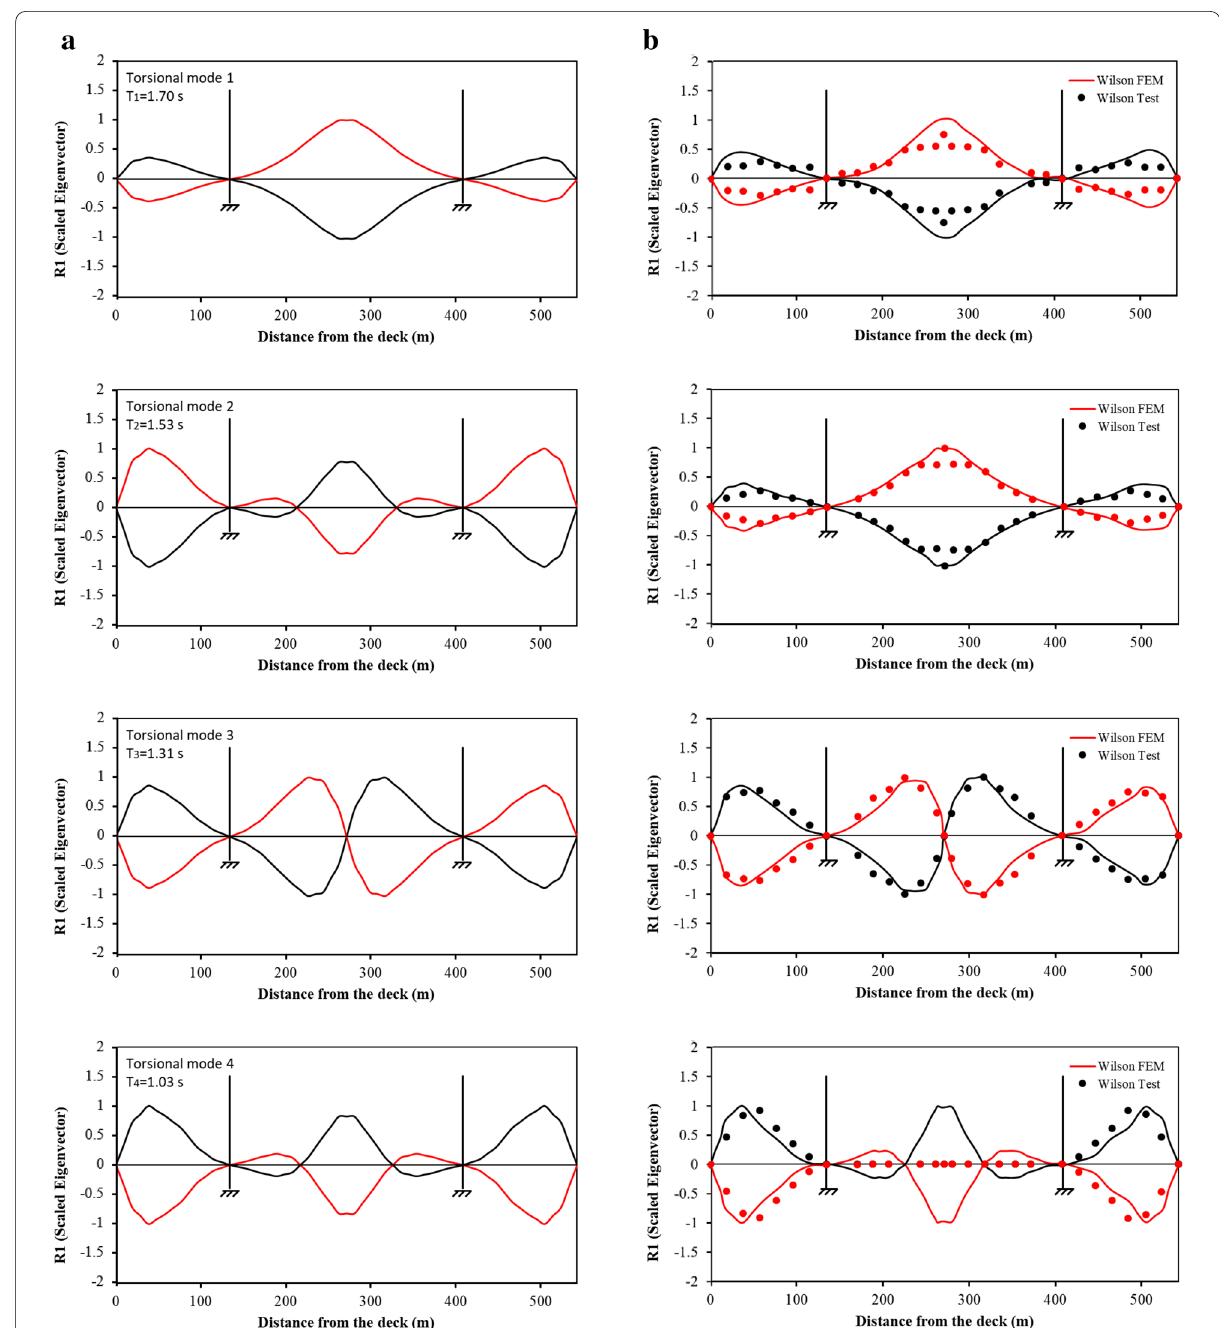
Fig. 4 Torsional mode shapes: a CFEM results, b Wilson FEM and Wilson test